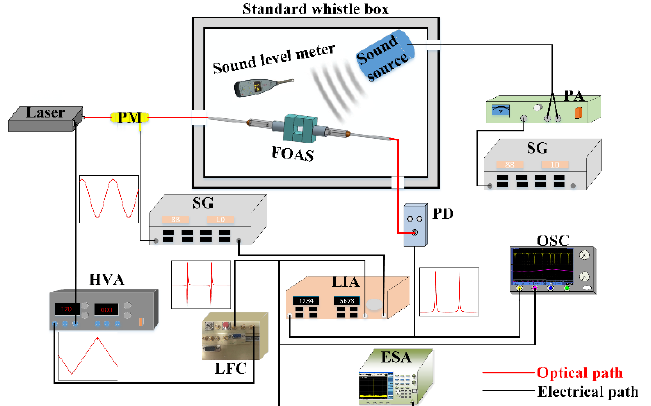
Figure 7. The acoustic performance test system diagram of FOAS. The optical path is drawn in red and the electrical path is drawn in black.